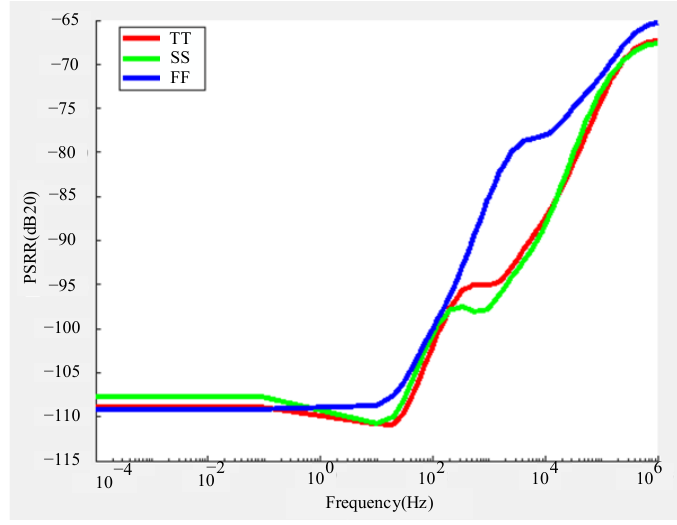
Figure 11. The measured PSRR of the proposed BGR circuit.